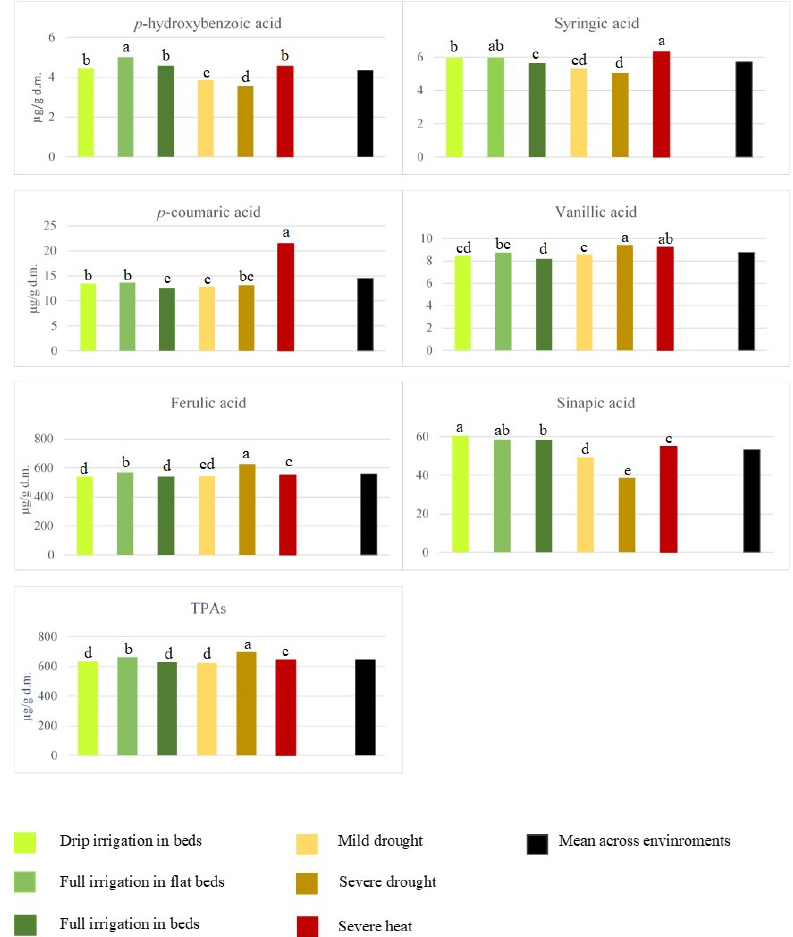
Figure 1. Average values of individual phenolic acids, evaluated in wholemeal flour of six CIMMYT durum cultivars over two years under six different growth conditions. TPAs: total sum of individual phenolic acids. Different letters show significant differences ( p < 0.05).